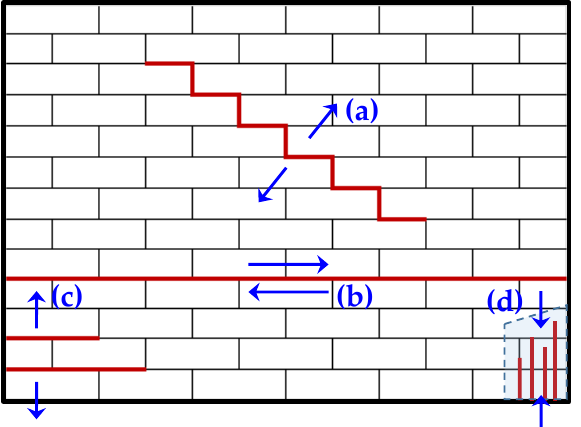
Figure 4. Illustration of the in-plane failure modes for a typical URM wall: ( a ) Diagonal tension failure, ( b ) sliding shear failure, ( c ) joint tension (flexural) failure, ( d ) toe-crushing failure.